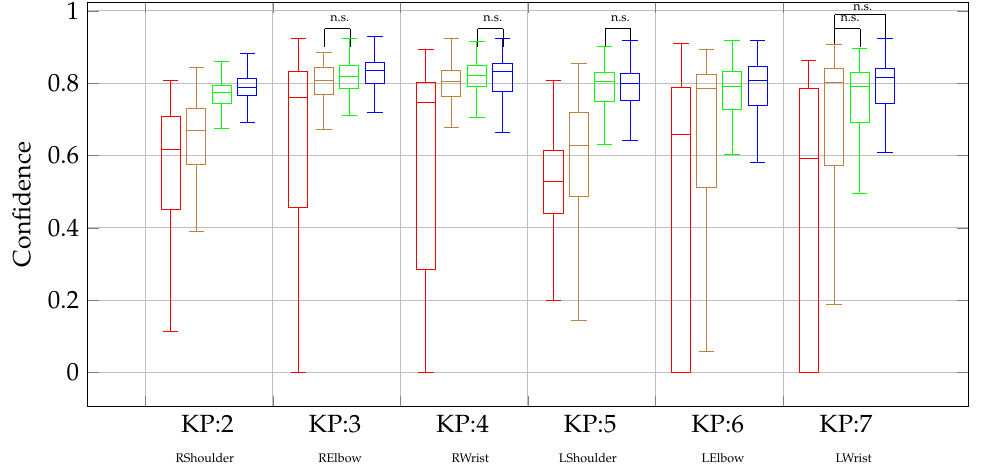
Figure 6. Confidence of detection of selected KP (keypoints)—¾ view, upper body. Camera views are shown in colour as follows: lying down ( N = 177); on the knees ( N = 95); sitting ( N = 165); and standing ( N = 490). All the other differences are statistically significant. Only differences that were not statistically significant (n.s.) are highlighted in the